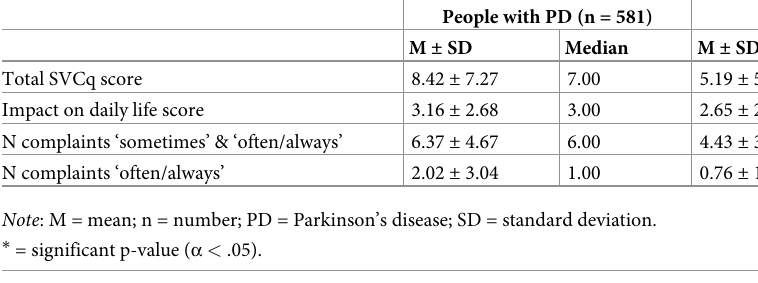
total score and the number of complaints (‘often/always’). Most medium effect sizes were found for the comparison between group 1 and � 4. Most measures did not indicate a difference between the sexes (see Table 7). Females did experience complaints significantly more frequently ‘often/always’. However, effect sizes were small. Age, disease duration, and LEDD showed significant positive correlations with all SVCq measures (see Table 8). Correlations were all weak [22].